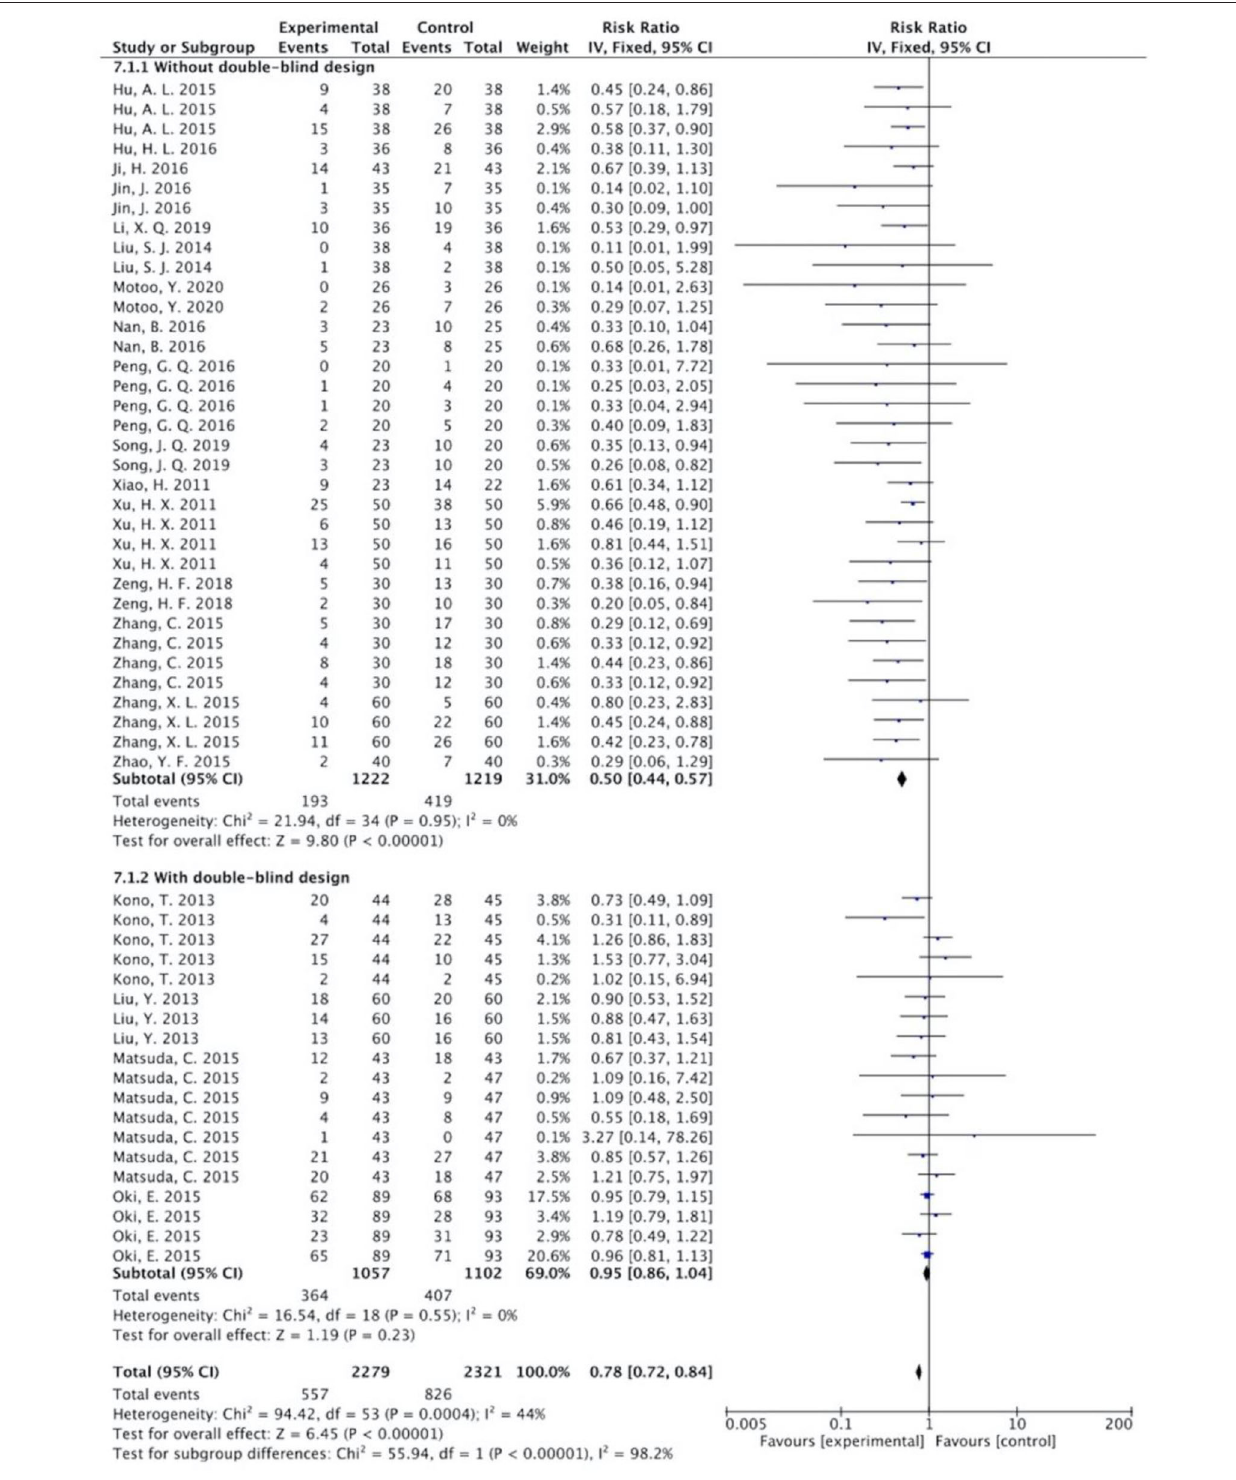
Frontiers in Oncology |